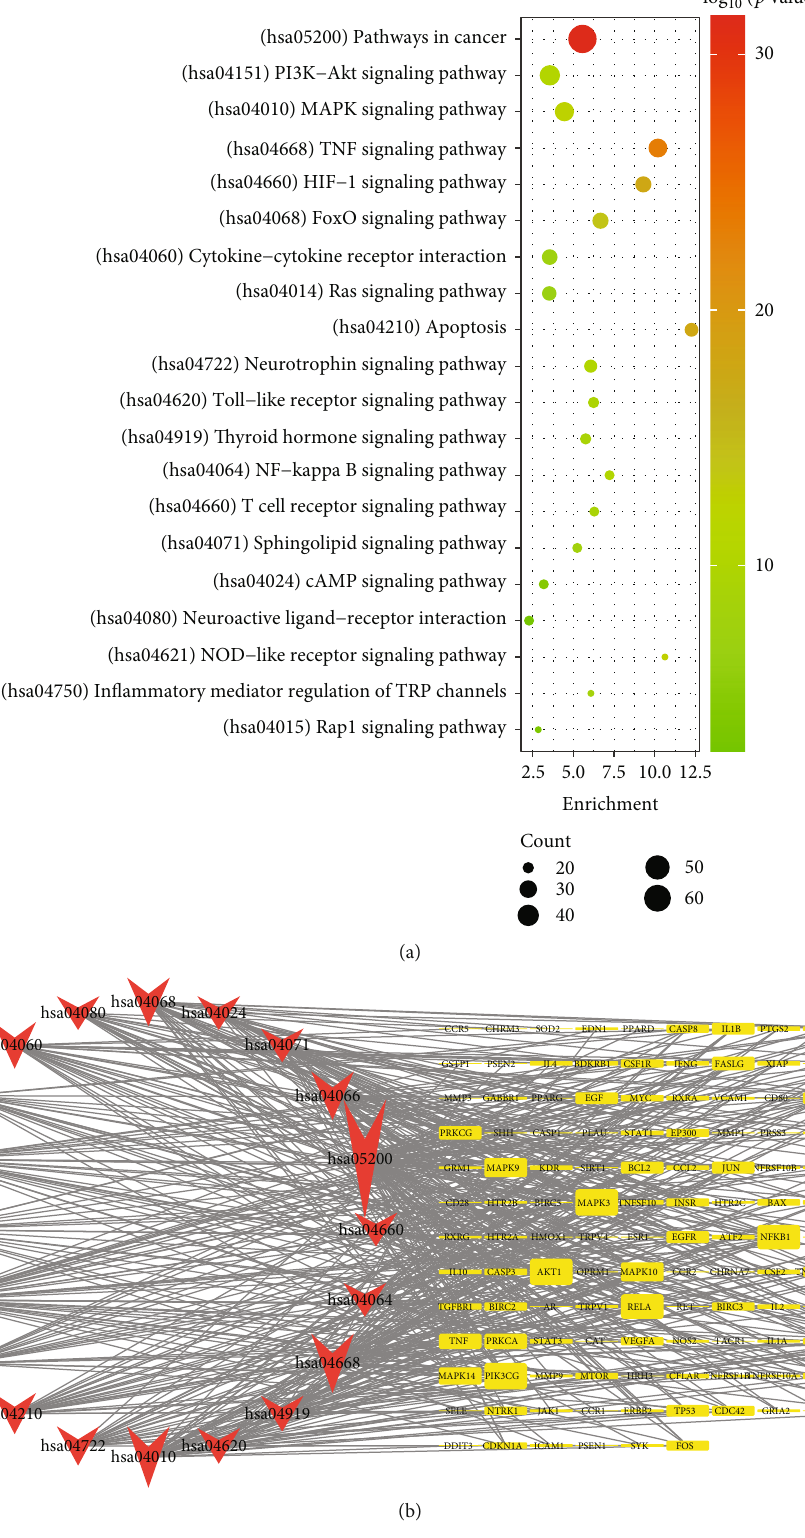
Figure 5: KEGG enrichment of potential targets of BSYS Capsule against CNSD. (a) The top 10 pathways with the highest count values were displayed (adj. P < 0 : 01 ). Sizes and colors of the spot represent the count value and P value, respectively. (b) The network of targets involved in the major pathways. The V-shapes and the squares represent pathways and target genes, respectively. The node degree is positively correlated with the shape